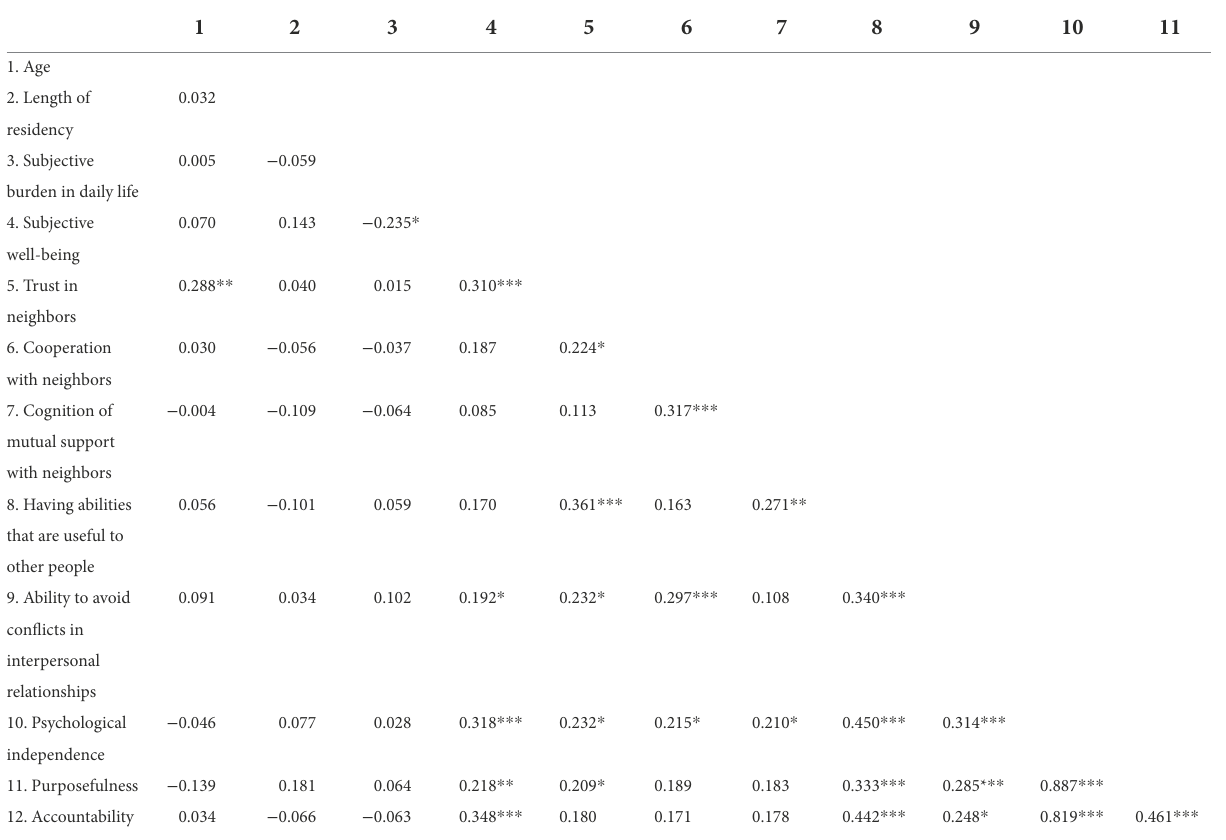
TABLE 2 Correlations between independent variables and psychological